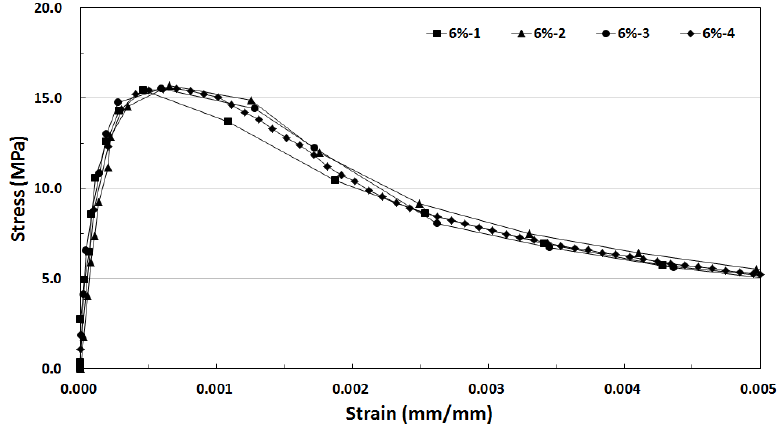
Figure 9. Tensile stress-strain curve of Slurry-Infiltrated Fiber-Reinforced Cementitious Composites (SIFRCCs) with 6% fiber volume fraction.